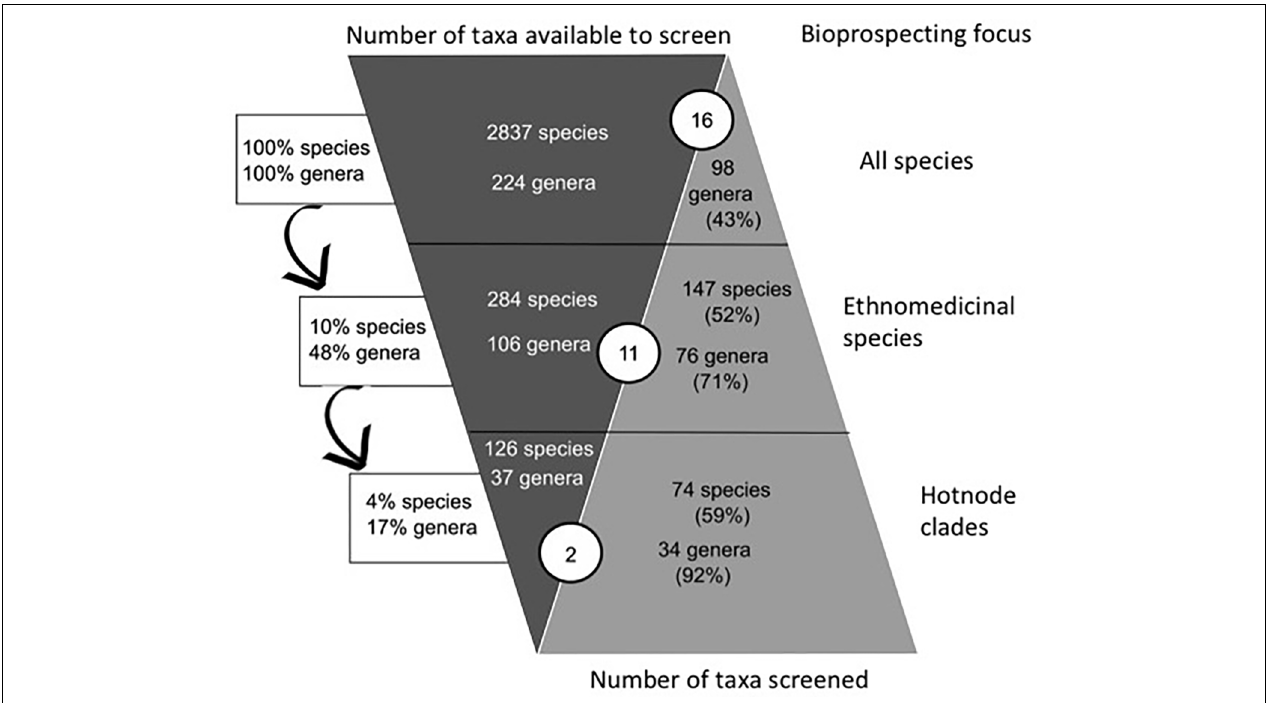
FIGURE 2 | Comparison of ethnomedicinal selection and pharmacological research effort. The left “column” (dark gray) shows the decreasing numbers of potential leads, if focus is on taxa (middle row) or lineages (bottom row) with ethnomedicinal use. This column shows that a focus on ethnomedicinal hotnode clades reduces the size of the species pool from 2837 species in total to 126 species that have ethnomedicinal use and are inside a hotnode clade. The arrows show the proportions of total flora represented in the samples, for example, the 126 species with ethnomedicinal use in the bottom row represent 4% of all species. This is 4% of all species. The right “column” (light gray) shows the proportion of these taxa that have been screened according to our survey. If focus is on the whole flora, there are 98 genera that have been investigated pharmacologically (43% of all genera). Considering the ethnomedicinally important lineages (bottom row), there are 34 genera with ethnomedicinal use and have been characterized pharmacologically that belong to hotnode clades (92% of the genera with ethnomedicinal use and in hot modes). The circled numbers in blue show the number of species that have yielded drugs approved for use or clinical trial by the FDA. As focus on ethnomedicinally important groups increases, there is a concomitant increase in research effort, but fewer drugs approved for use or clinical trial by the